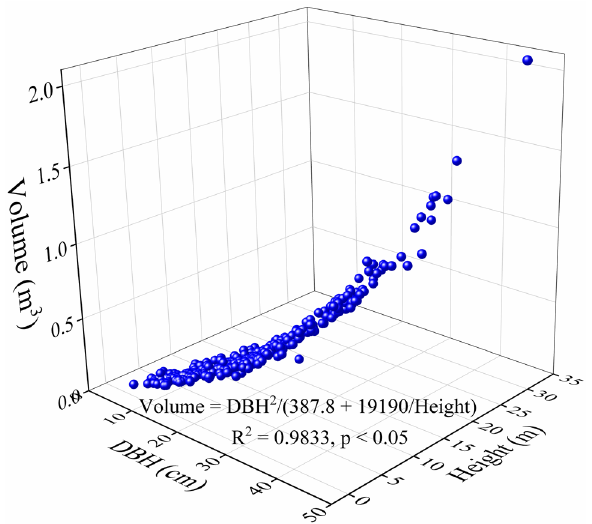
Figure 3. Relationships of Volume against diameter at breast height (DBH) and Height, Volume = DBH 2 / (387.8 + 19,190/Height) (R 2 = 0.9833, p < 0.05).